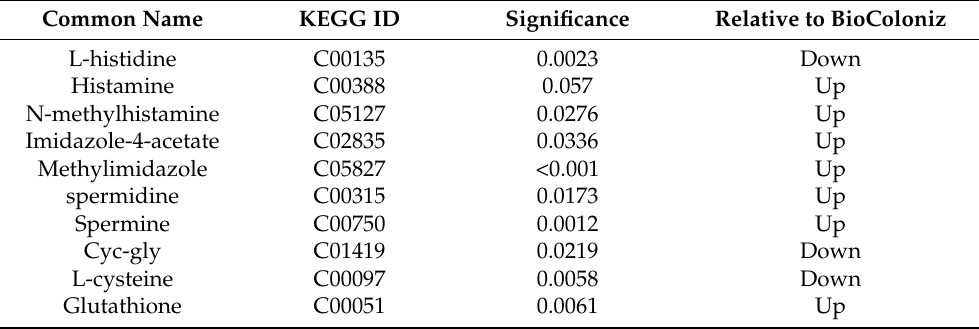
Table 5. Significant features involved in histamine degradation and glutathione metabolism